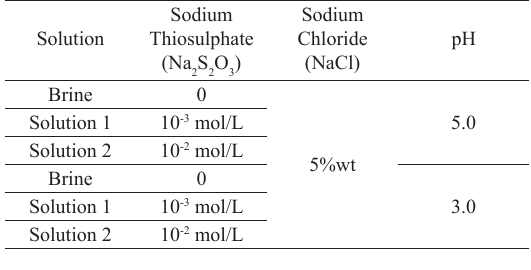
Table 2. Chemical composition of the solutions used in electrochemical